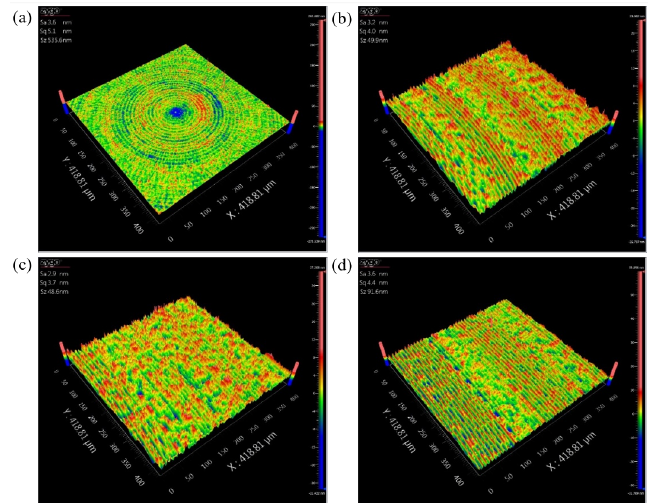
Figure 14. Surface morphology and measured roughness of the convex mould at different slope degrees under optimised parameters: ( a ) 0°, ( b ) 5°, ( c ) 10°, and ( d )